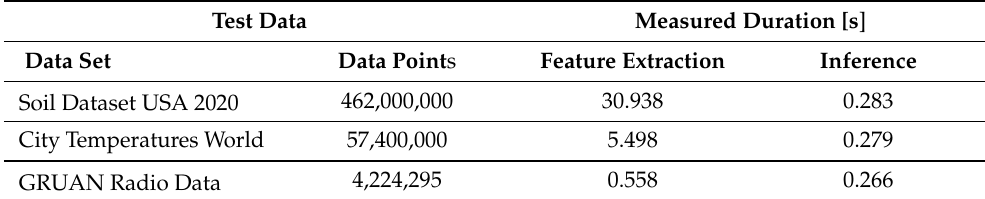
Table 3. Measurement of duration of feature extraction and inference for three test data sets.